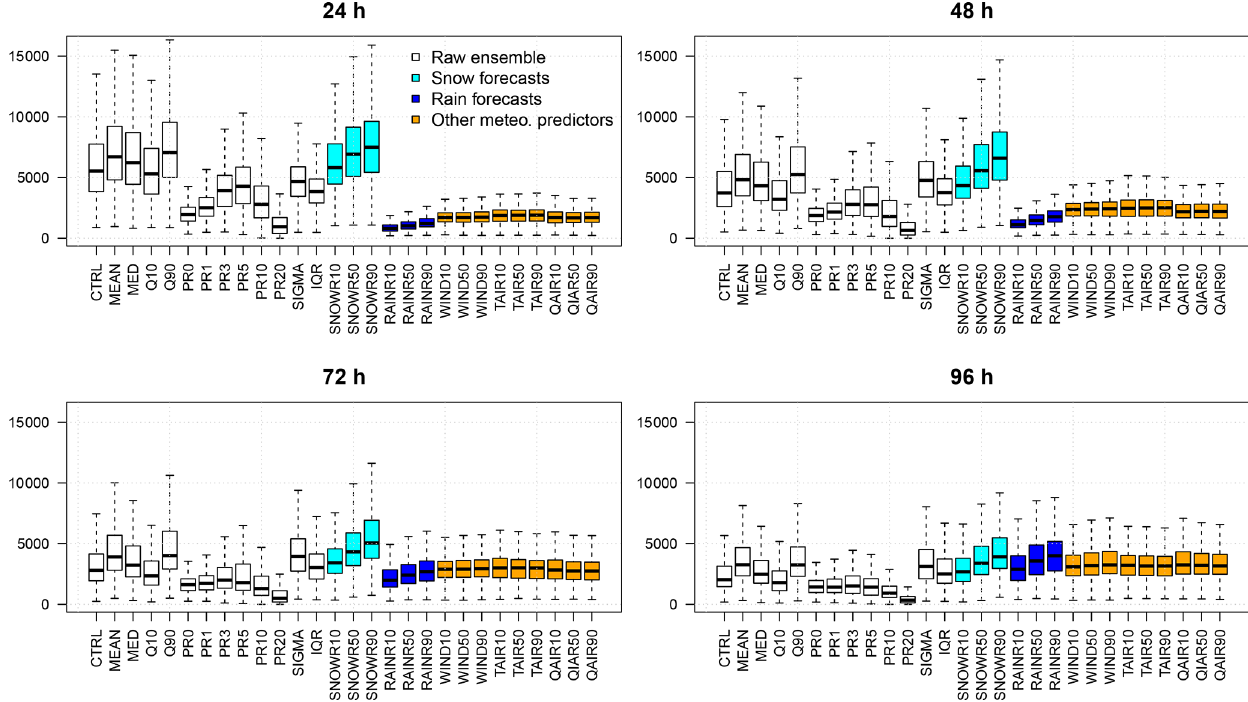
Figure 2. Importance criteria (sum of squares of the differences between predicted and observed response variables, averaged over all trees obtained with the random permutations) of the predictors for different lead times for the QRF method. Table 2. Mean and standard deviation (SD) of the width of the predictive intervals (PIs; 50% and 90% nominal coverages), with the different methods and for all locations and dates, for a 1d lead time. The width associated to a 50% probability corresponds to the difference between the 25th and 75th percentiles, and the width for a 90% probability corresponds to the difference between the 5th and 95th